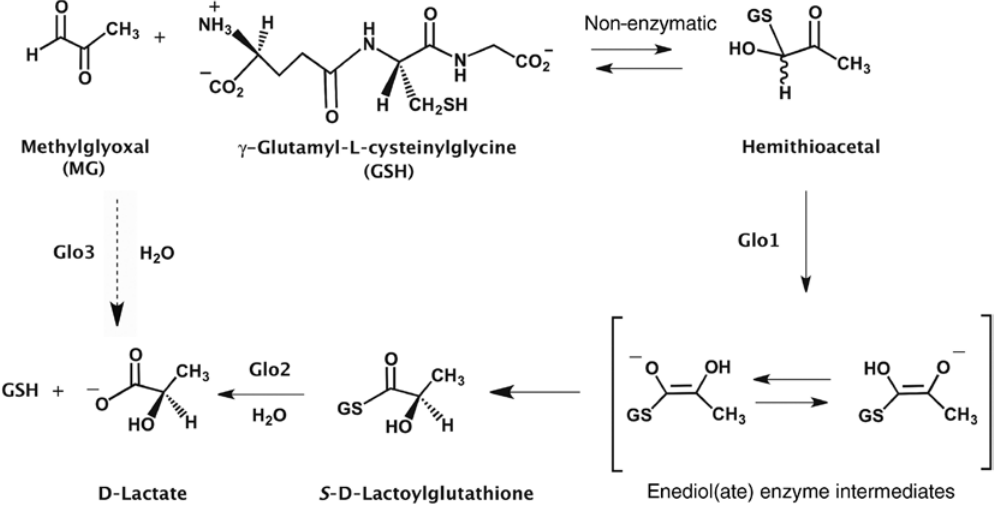
Figure 1: Reaction schemes for the glyoxalase enzymes.